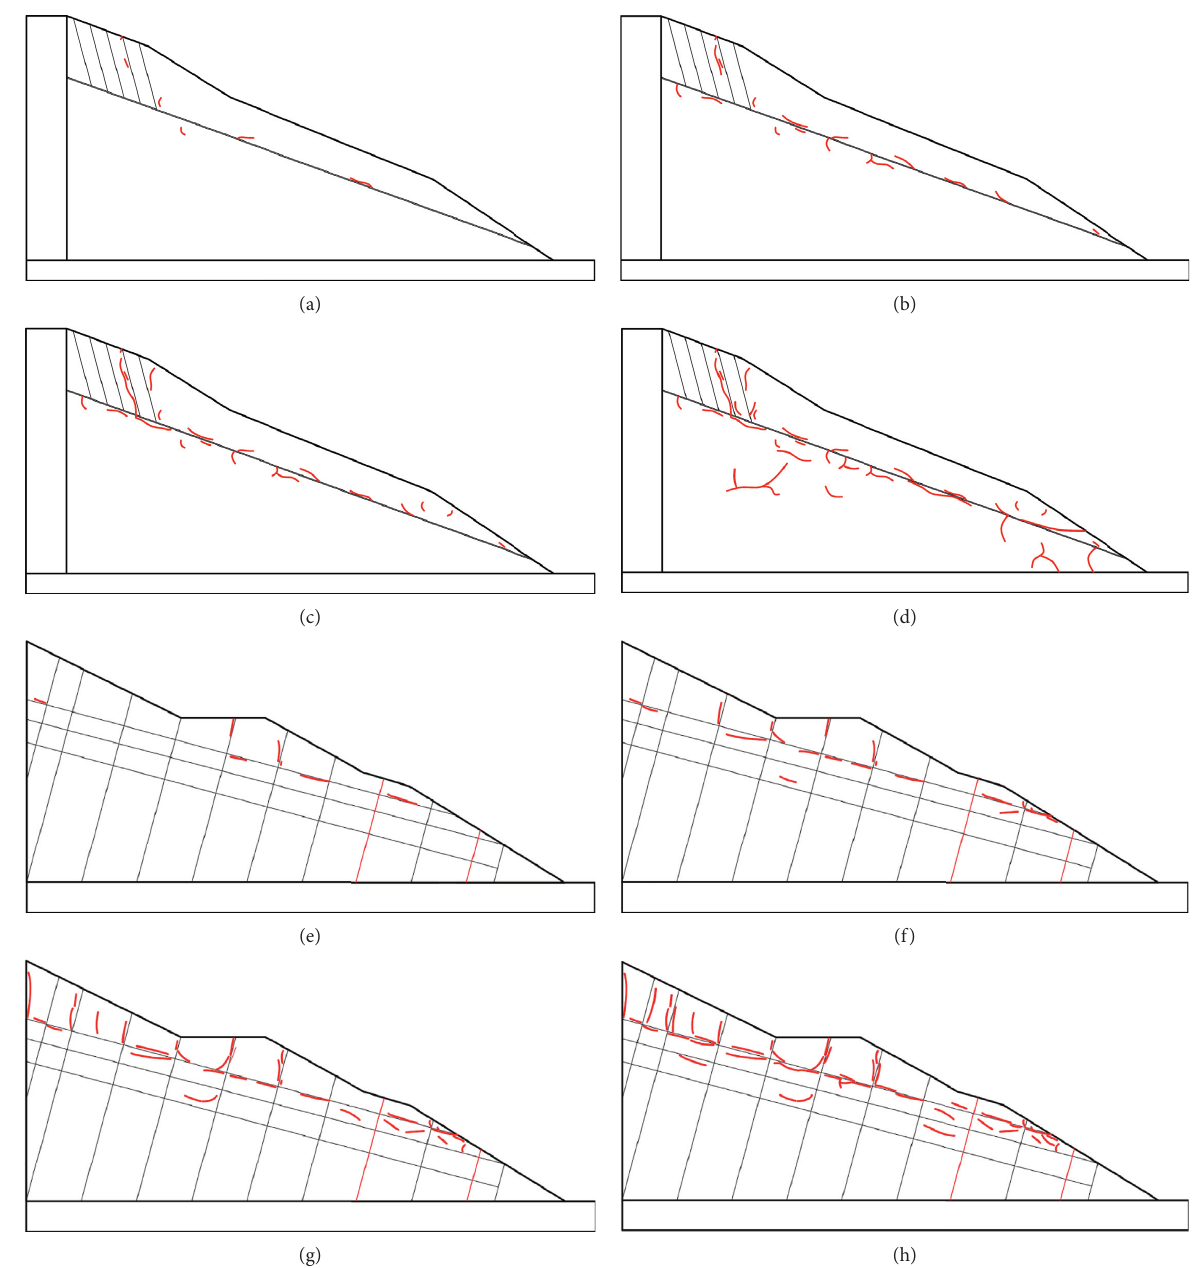
Figure 17: The dynamic damage process of the slopes: (a) Huaping slope (0.074 g in z direction); (b) Huaping slope (0.074 g in x direction); (c) Huaping slope (0.297 m/s 2 in z direction); (d) Huaping slope (0.446 g in x direction); (e) Lijiang slope (0.168 g in z direction); (f) Lijiang slope (0.168g in x direction); (g) Lijiang slope (0.504 g in z direction); (h) Lijiang slope (0.504 g in x